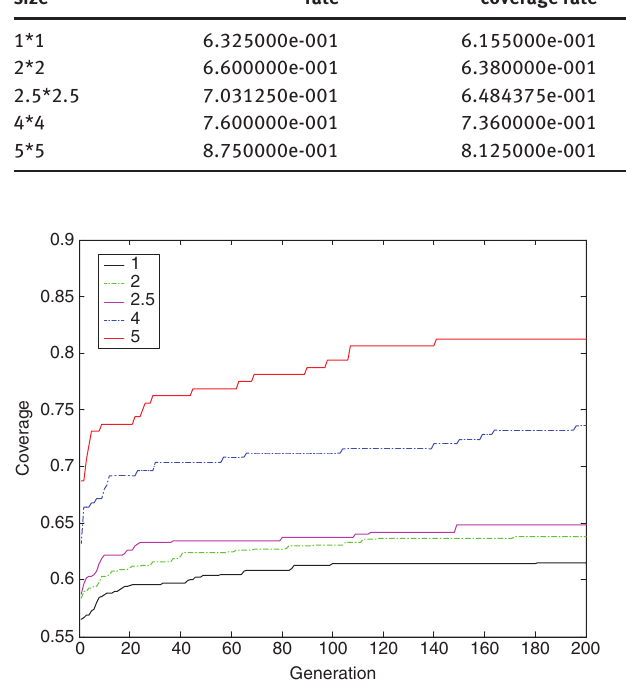
Table 4: The Statistical Results about the Influence of the Raster Size on Coverage Performance. Raster